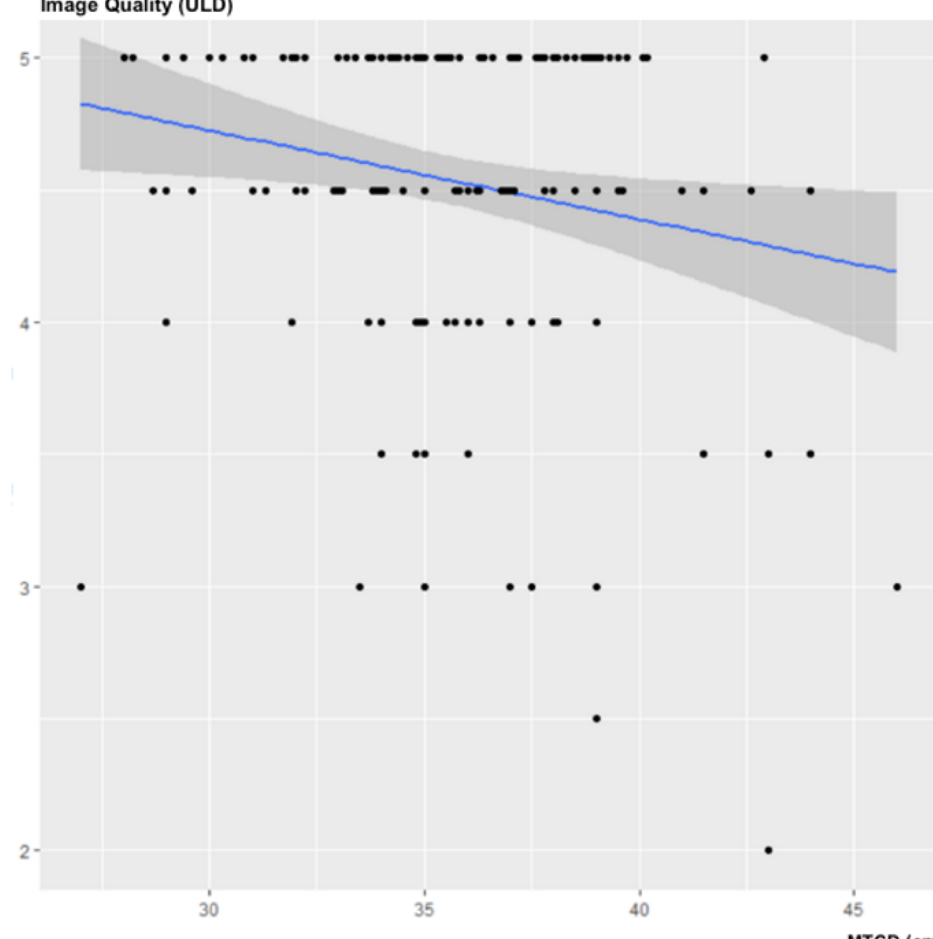
Figure 5. Influence of the MTCD on subjective image quality.